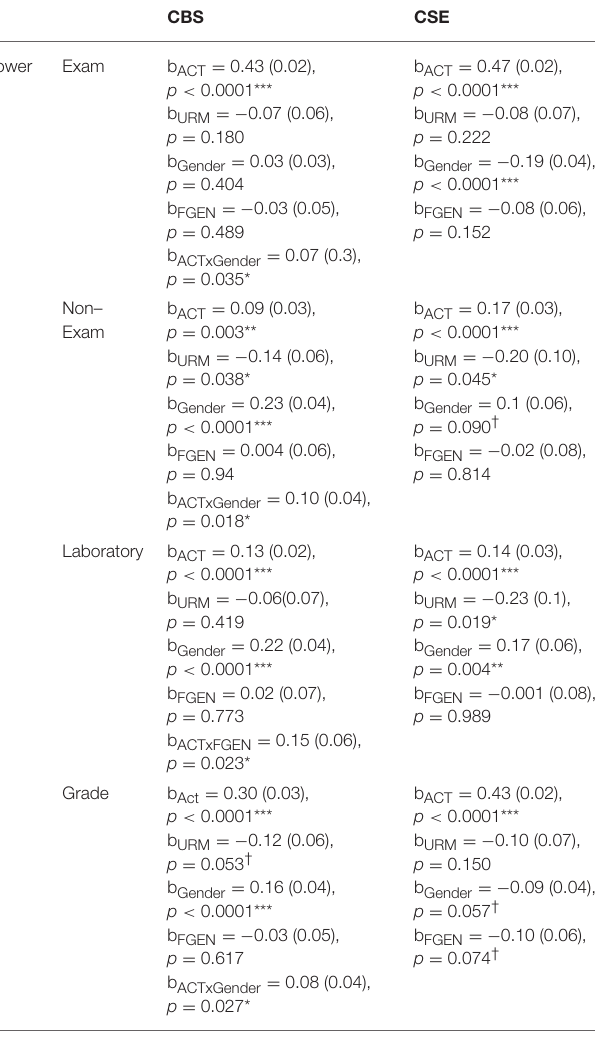
TABLE 4 | Regression estimates for the gender gap in performance in lower division courses in the College of Biological Sciences (CBS) and the College of Science and Engineering (CSE) across different assessment methods, including the overall course grade.